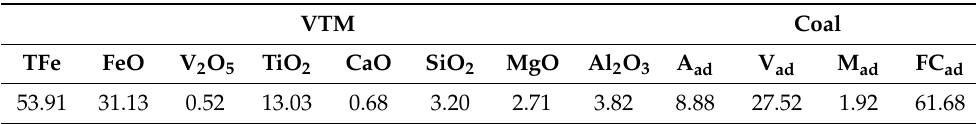
Table 1. Chemical compositions of VTM and industrial coal (mass%). VTM